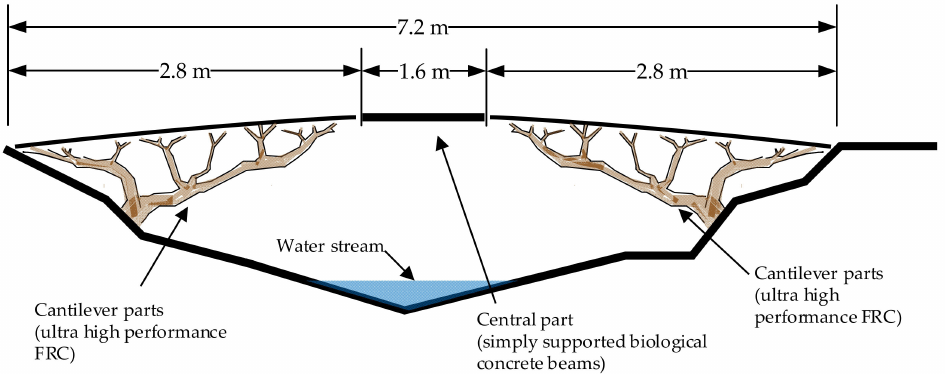
Figure 1. Design of bridge